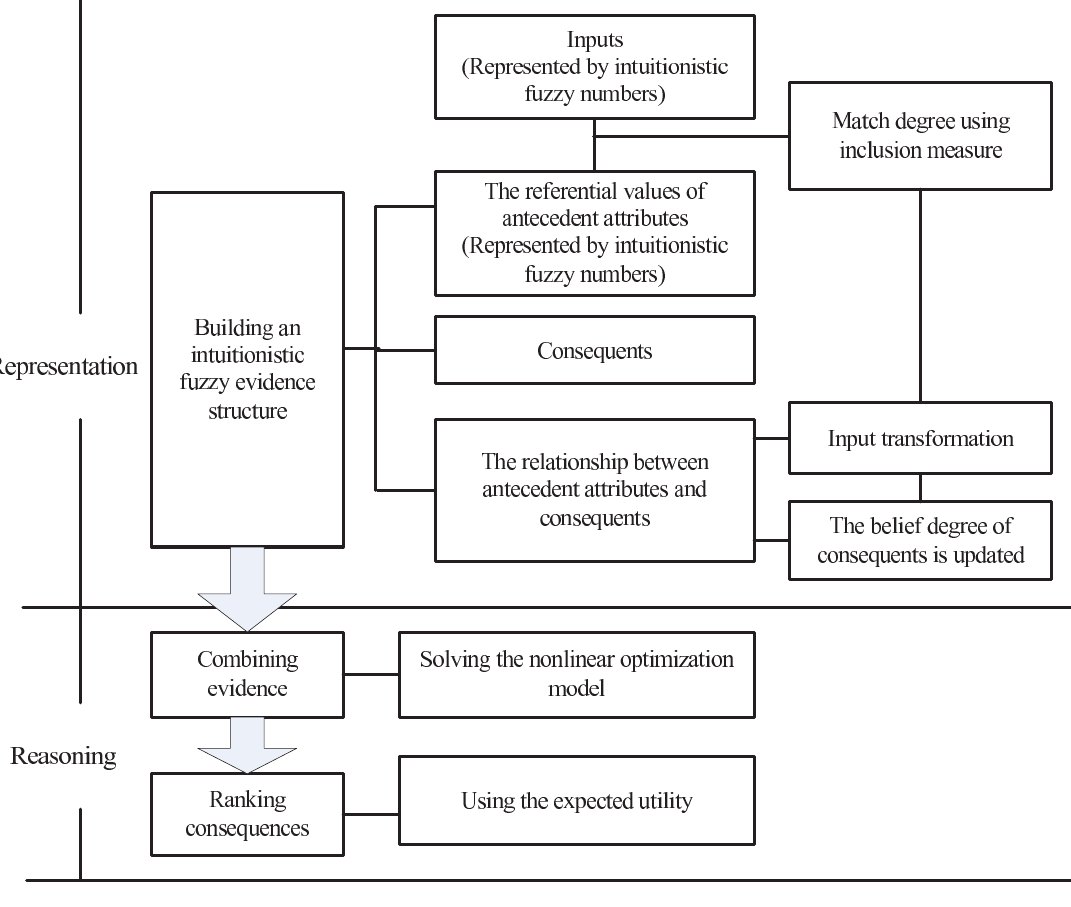
Fig. 1. The flowchart of intuitionistic fuzzy evidential rea- soning